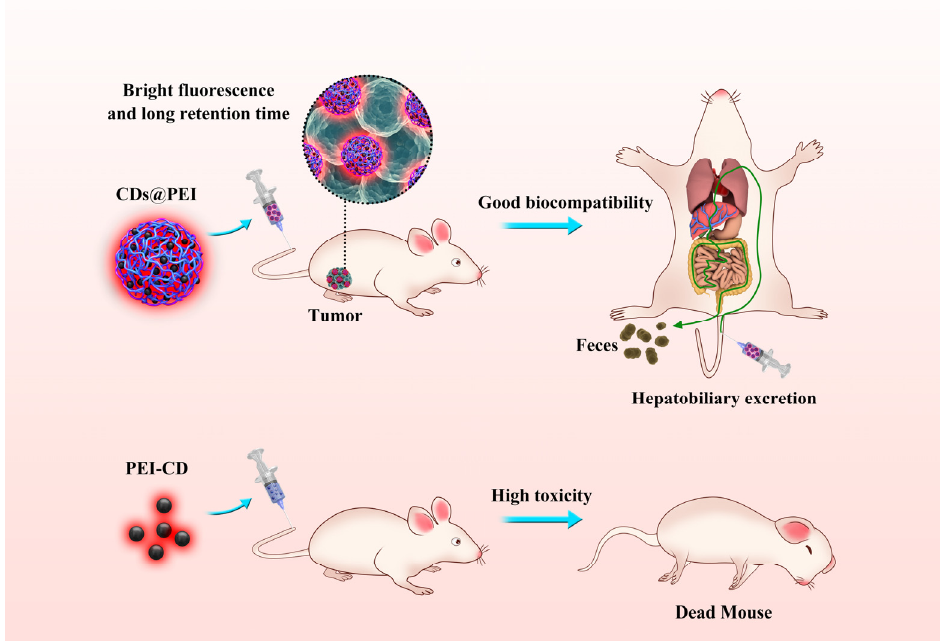
Figure 1. Top: The biodistribution, clearance, and systemic biocompatibility of CDs@PEI nanoparti- cles in mice; bottom: PEI ‐ CD single carbon dots showed high toxicity in the animal.